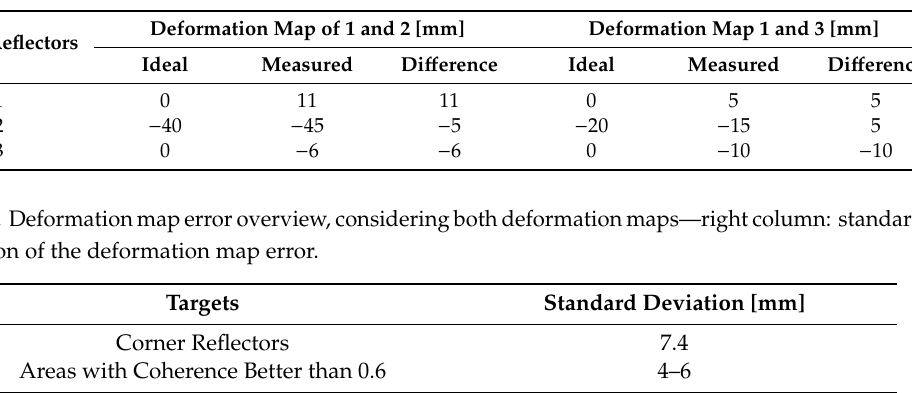
Table 3. Results overview of the two deformation maps.